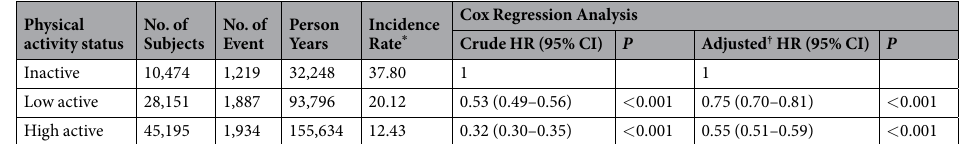
Table 3. Association Between Physical Activity Status and Mortality in Older Participants. * Per 10 3 person years. † Adjusted for age, sex, body mass index, smoking, alcohol use, systolic blood pressure, diastolic blood pressure, hypertension, diabetes mellitus, coronary artery disease, cerebrovascular disease, white blood cell count, hemoglobin, albumin, geriatric nutritional risk index, uric acid, fasting glucose, estimated glomerular filtration rate, and urine protein level. Abbreviations: HR, Hazard ratio; CI, confidence interval; HDL, high- density